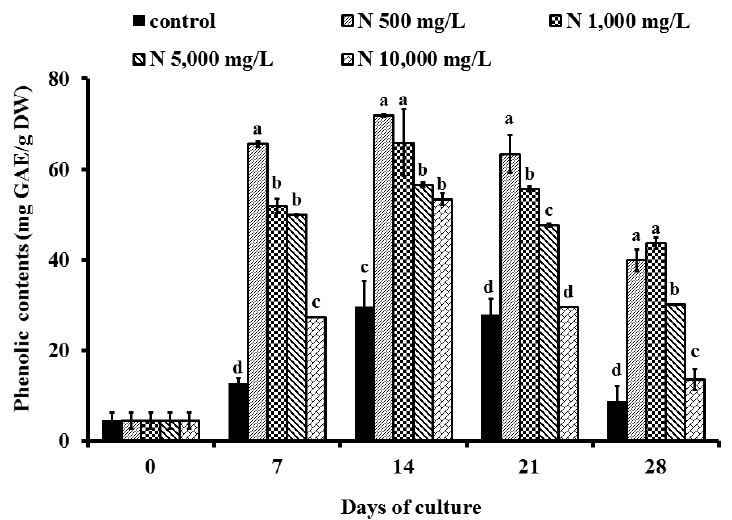
Figure 2. Effect of ammonium nitrate 0, 500, 1,000, 5,000 and 10,000 mg/L (control, N 500 mg/L, N 1,000 mg/L, N 5,000 mg/L and N 10,000 mg/L) on phenolic